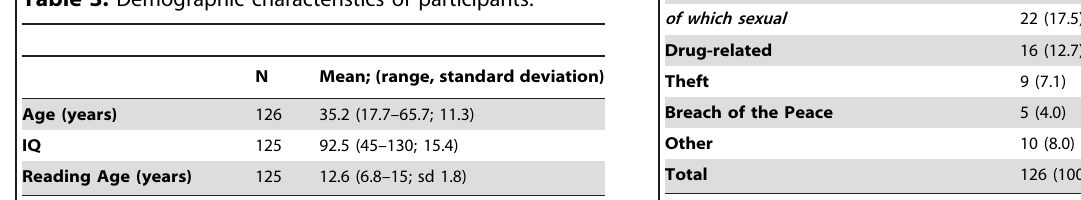
Table 3. Demographic characteristics of participants.